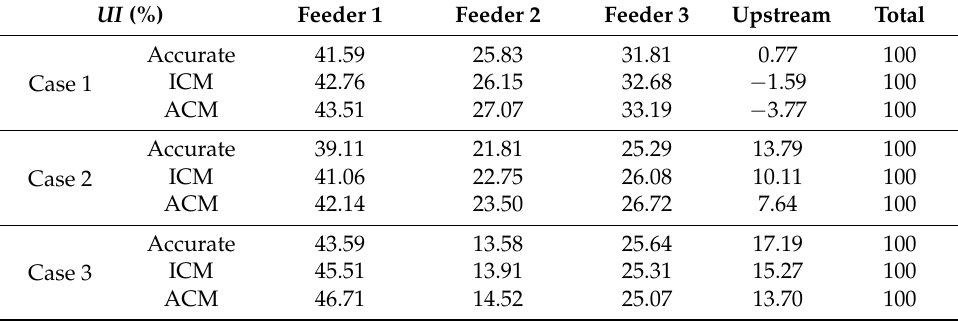
Table 5. Estimation results for the unbalance contribution. ICM: the results for the “individual current”-based method; and ACM: the results for the “actual current”-based